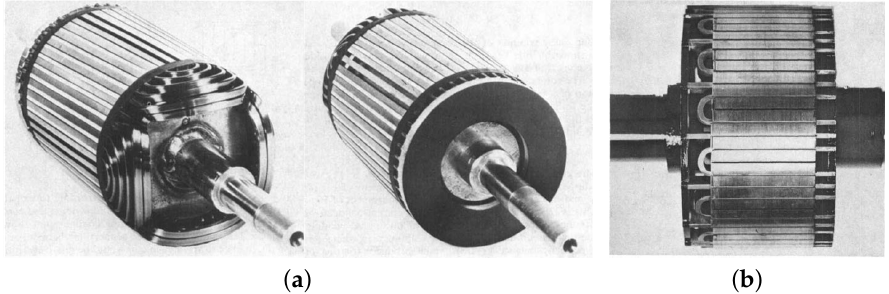
Figure 6. Broadway & Burbridge rotor prototypes: ( a ) Graded winding rotor for (6 + 2) poles machine, and ( b ) multicircuit rotor for (18 + 12) poles machine